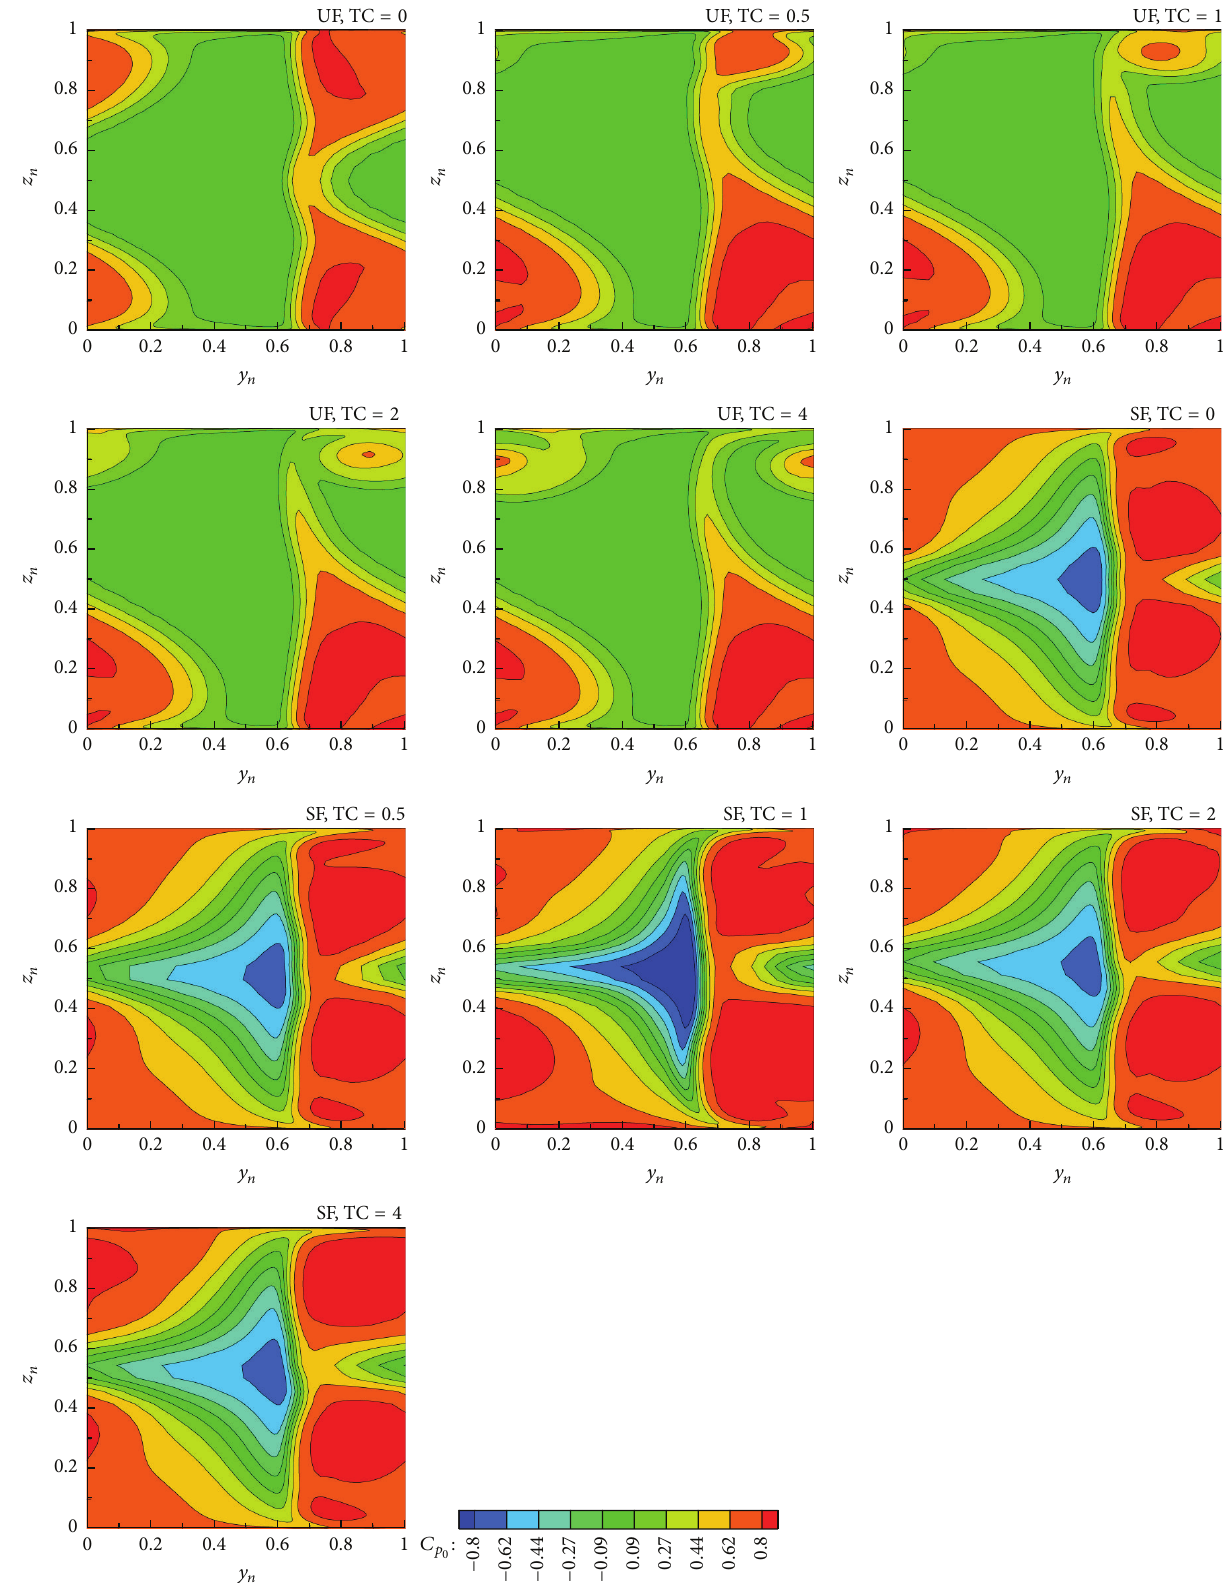
Figure 8: 𝐶 𝑝 contours in the wake with UF and SF for TC = 0 to 0